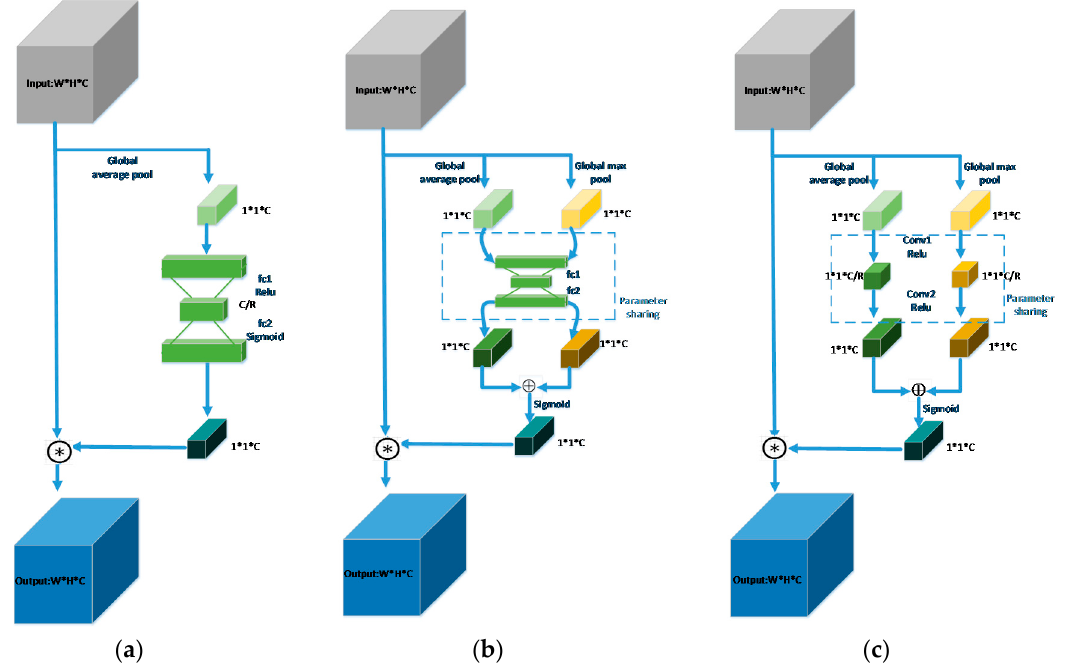
Figure 4. Different channel attention blocks. ( a ) SE block; ( b ) CA block; ( c ) the Full Convolutional Channel Attention (FCCA) block.